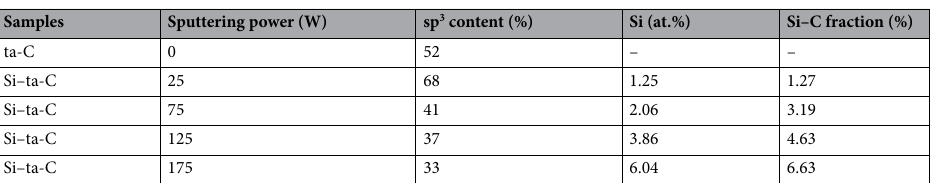
Table 1. sp 3 content, Si atomic ratio in survey spectra, and Si–C fraction in C1s spectra of the tetrahedral amorphous carbon (ta-C) and Si/SiC/ta-C composite (Si–ta-C) coatings as a function of sputtering power during ta-C deposition using XPS.